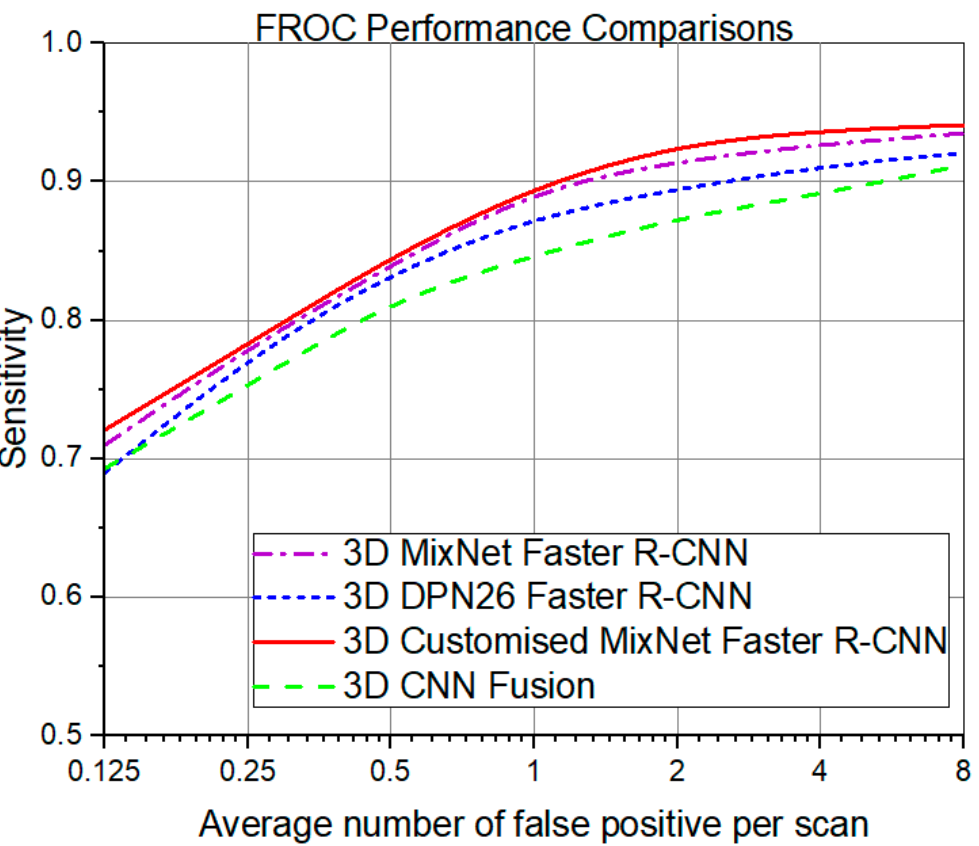
Figure 9. Comparison of different FROC curves obtained from deep learning models.